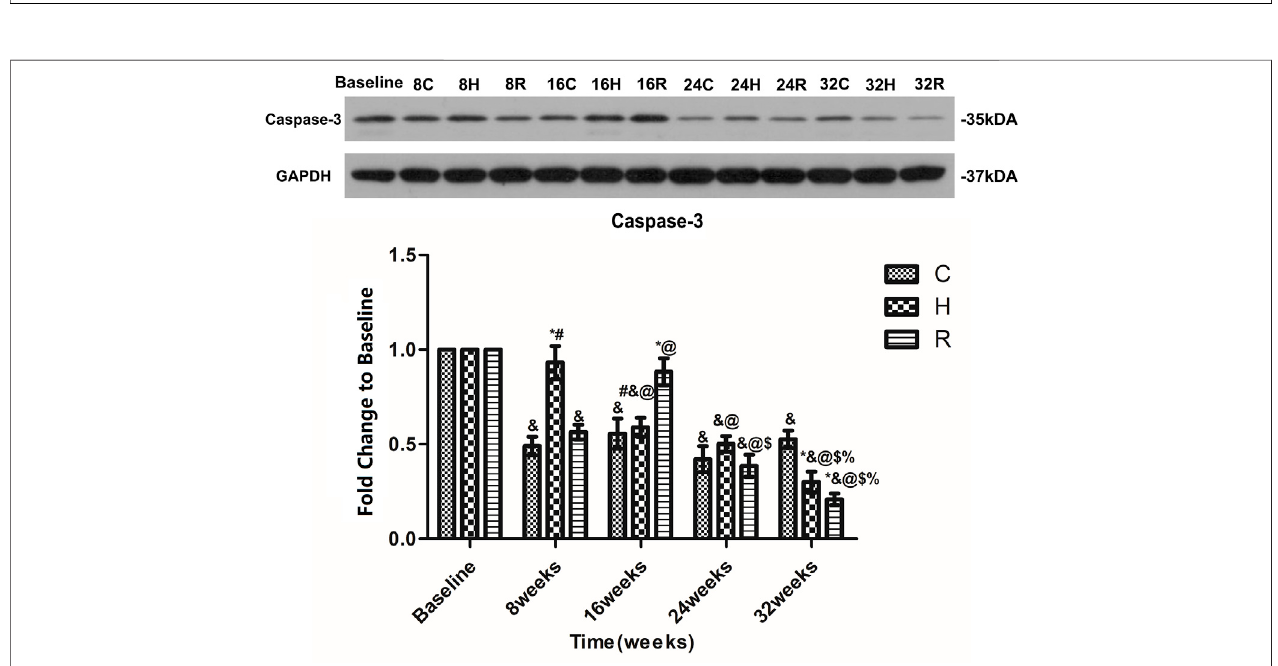
FIGURE 9 | Age and exercise training effects on Caspase-3 levels in mitochondria of soleus muscle, were evaluated by Western blot. * Signi fi cant different from C and other group; # Signi fi cant different from H and R; & Signi fi cant different from Baseline and other weeks; @ Signi fi cant different from 8 weeks and other weeks; $ Signi fi cant different from 16 weeks and other weeks; % Signi fi cant different from 24 weeks and other weeks. ( p < 0.05).